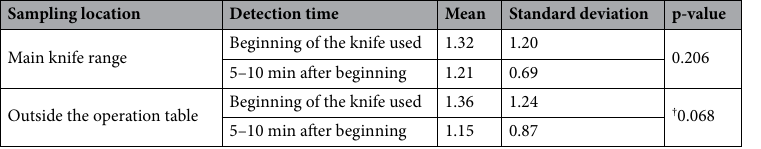
Table 4. The analysis of the concentration number of formaldehyde detected at different time points. † 0.05 < p < 0.1,*p < 0.05.